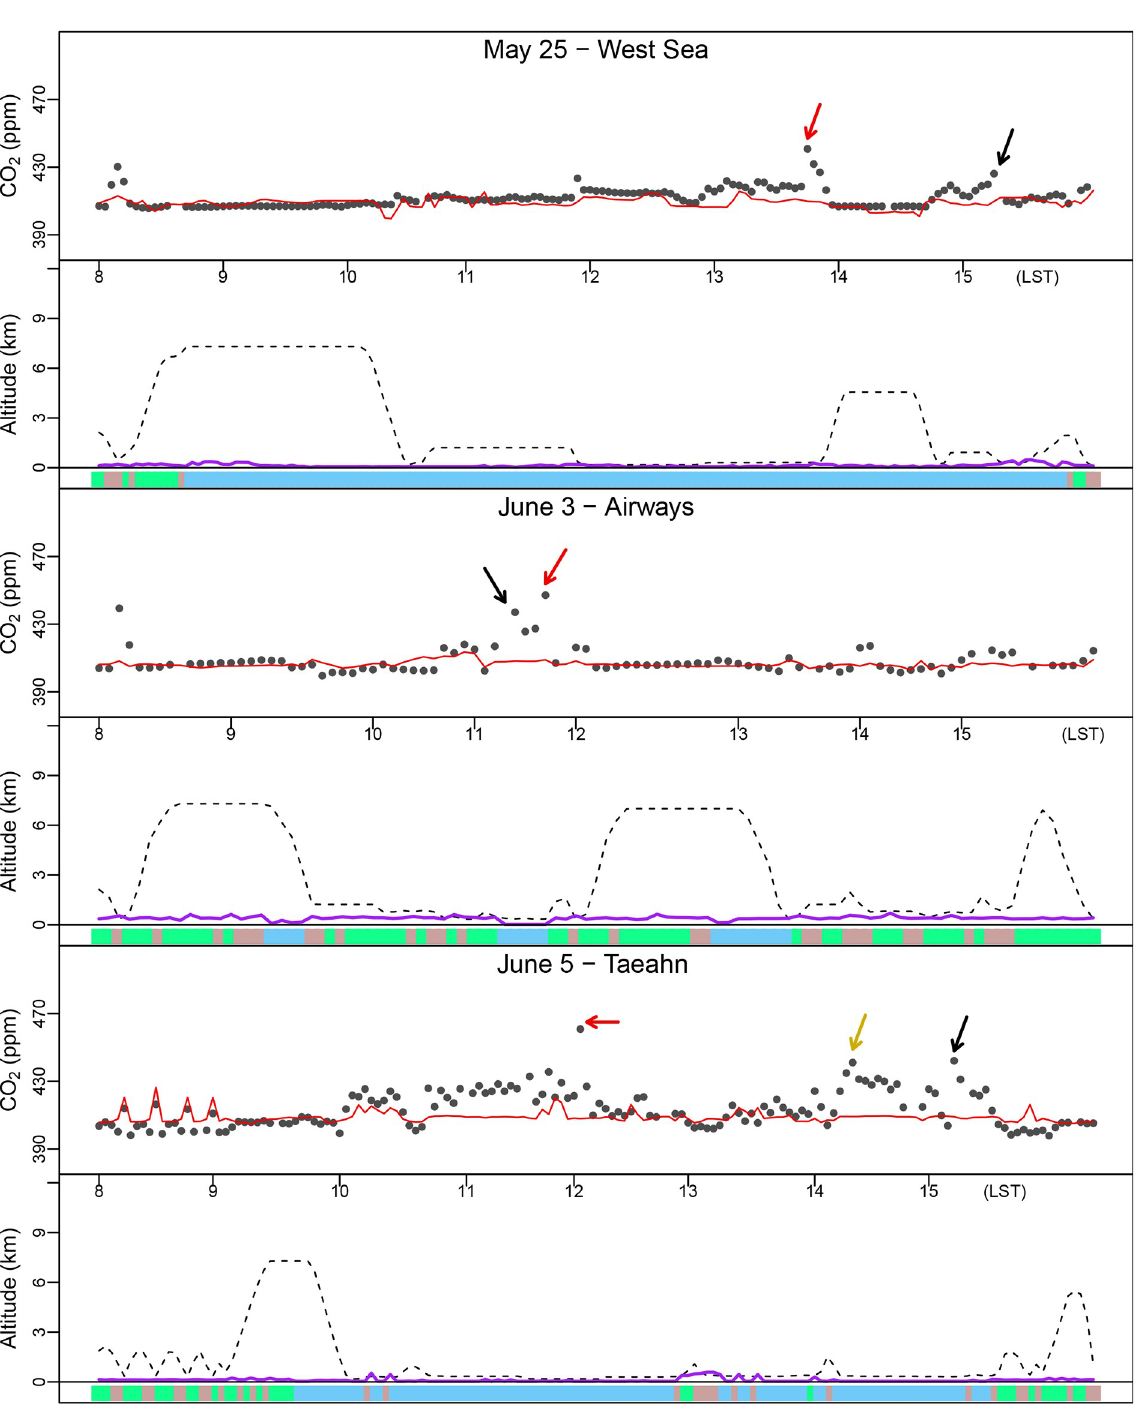
Fig 6. Time series of CO 2 concentrations, simulated (red solid lines) and observed (black dots), in each upper panel; and DC-8 flight altitude (black dashed line) and simulated PBLH (purple solid line) over the land use with color code in each bottom panel. Land-cover types at the aircraft locations are represented by color codes as Fig 1. The colored arrows indicate the dominant peaks and their flight locations are marked in Fig 5.